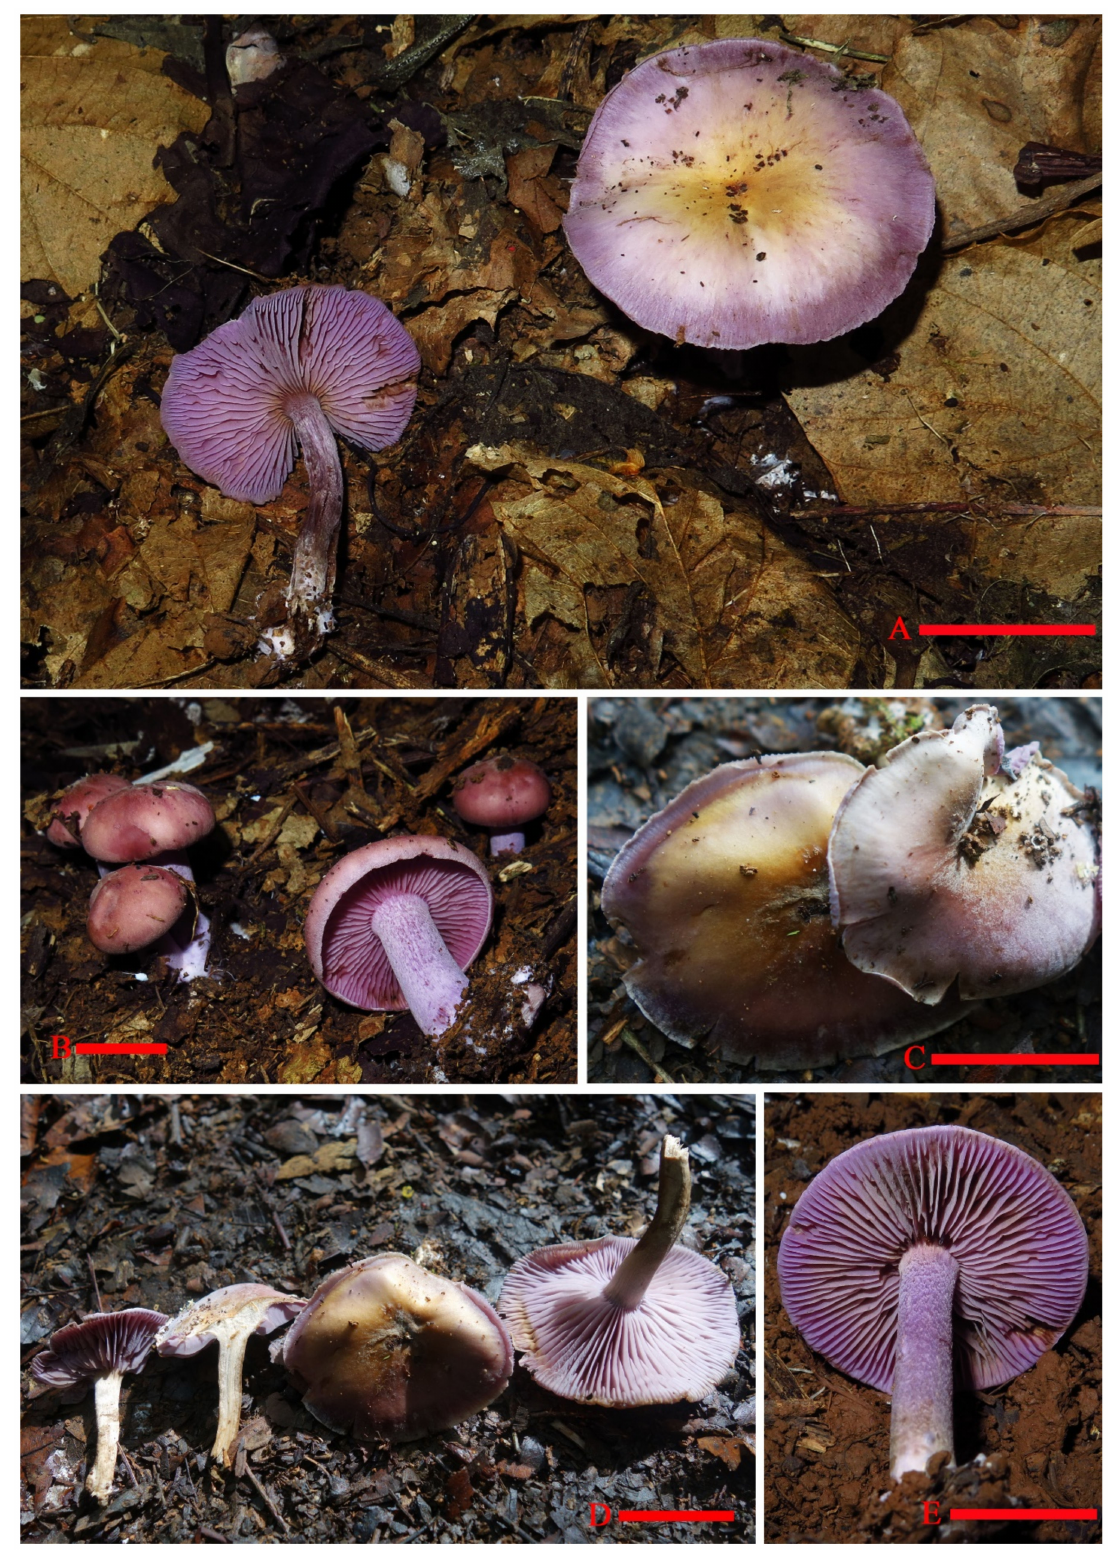
Figure 8. Basidiomata of Tricholosporum guangxiense . Scale bar ( A – D ) = 2.5 cm. A from HMJAU59028 (Holotype HMJAU), ( B ) from HMJAU59027 , ( C , D ) from HMJAU59023 , and ( E ) from M2021082208 (IBK). Photos by Guang-fu